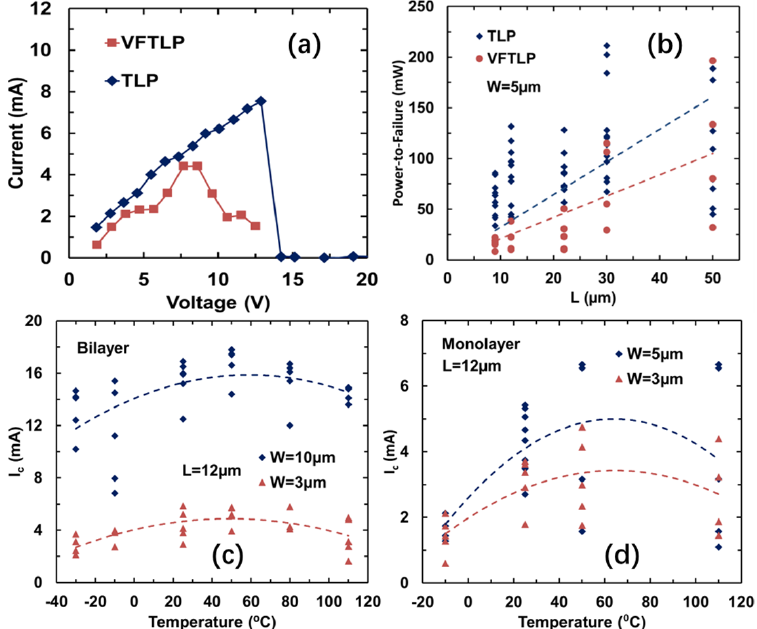
Figure 18. Measurement of graphene ESD interconnects: ( a ) measured ESD I–V curves for a bilayer GR sample ( L = 12 µm, W = 5 µm) in TLP and VFTLP tests; ( b ) statistics of P C –L relationship of GR samples under TLP and VFTLP stresses; ( c ) bilayer graphene interconnects under TLP stress with varying temperature from − 30 °C to 110 °C; ( d ) monolayer graphene interconnects under TLP stress with varying temperature from − 30 °C to 110 °C.